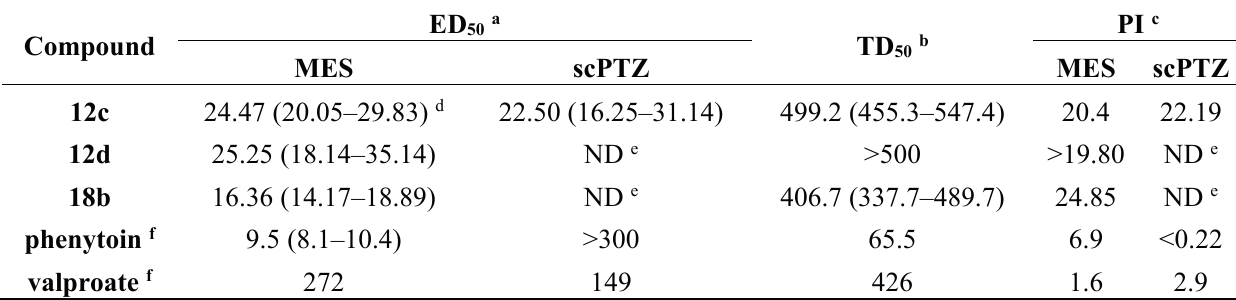
Table 2. Quantitative anticonvulsant data in mice dosed